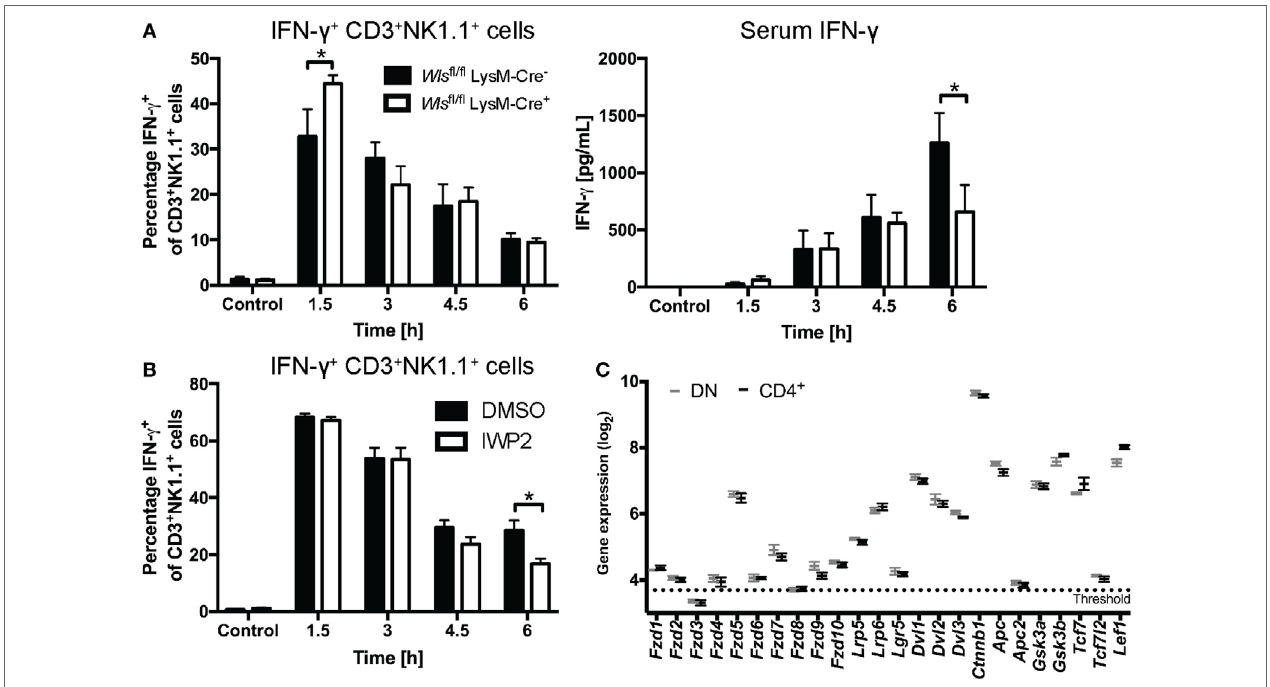
FigUre 6 | Wnt proteins secreted by myeloid cells upon α -galactosylceramide ( α -GalCer) challenge regulate the interferon gamma (IFN- γ ) response. (a) Mice with a conditional knockout of Wls ( Wls fl/fl LysM-Cre + ) and littermate controls ( Wls fl/fl LysM-Cre − ) were challenged with α -GalCer. Percentages of CD3 + NK1.1 + natural killer T (NKT) cells expressing IFN- γ in the liver, and the serum levels of IFN- γ were analyzed. Data are means ± SEM of four to six mice per genotype ( n = 2 for 4.5 h Wls fl/fl LysM-Cre − group) per time point cumulatively analyzed in four independent experiments. (b) Percentages of CD3 + NK1.1 + NKT cells expressing IFN- γ was determined by flow cytometry in mice treated with DMSO or the Porcupine inhibitor, IWP2. Data are means ± SEM of four to nine mice per treatment for each time point from two to three independent experiments. At each time point, groups in panels (a,b) were compared using unpaired two-sided t -test; * p < 0.05. (c) Mircoarray-based gene expression analyses of sorted CD4 − (and CD8-negative, DN) and CD4 + liver NKT cells were analyzed for the expression of Wnt signaling components. Data are presented as mean ± SEM. The threshold was set at the expression level of Il12a , which is not expressed by NKT